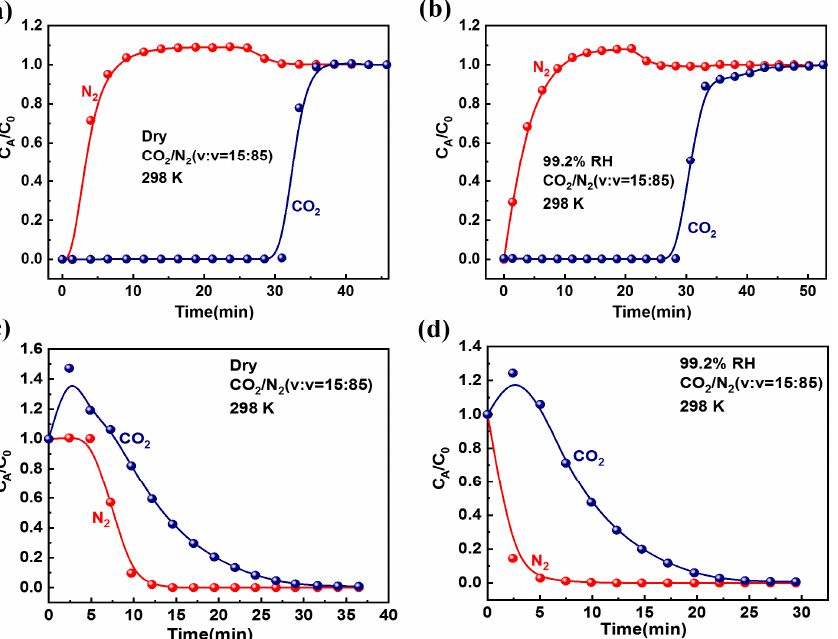
Figure 3. Experimental breakthrough and desorption curves for CO 2 /N 2 mixture (15/85, v / v ) under two humidity conditions: ( a , c ) dry gas and ( b , d ) wet gas (99.2% RH). two humidity conditions: ( a , c ) dry gas and ( b , d ) wet gas (99.2%